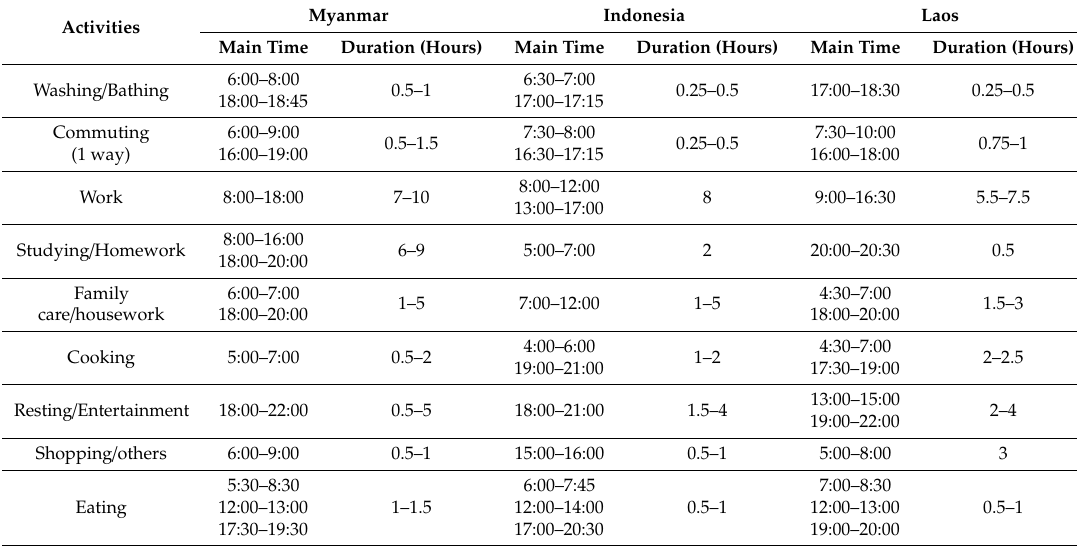
Table 3. Main time and duration of energy related activities in each case study village from the time-use questionnaire.